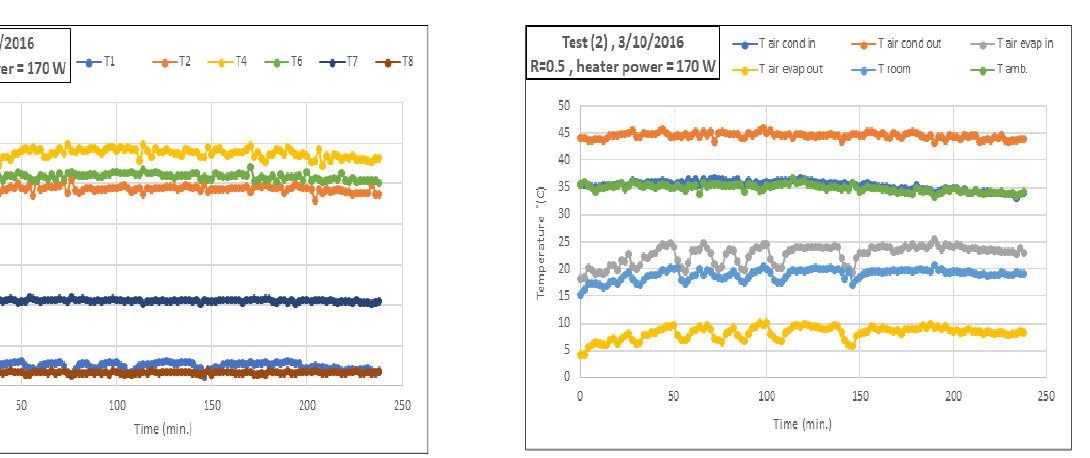
Fig. 10b. Air temperature with time for test 2.